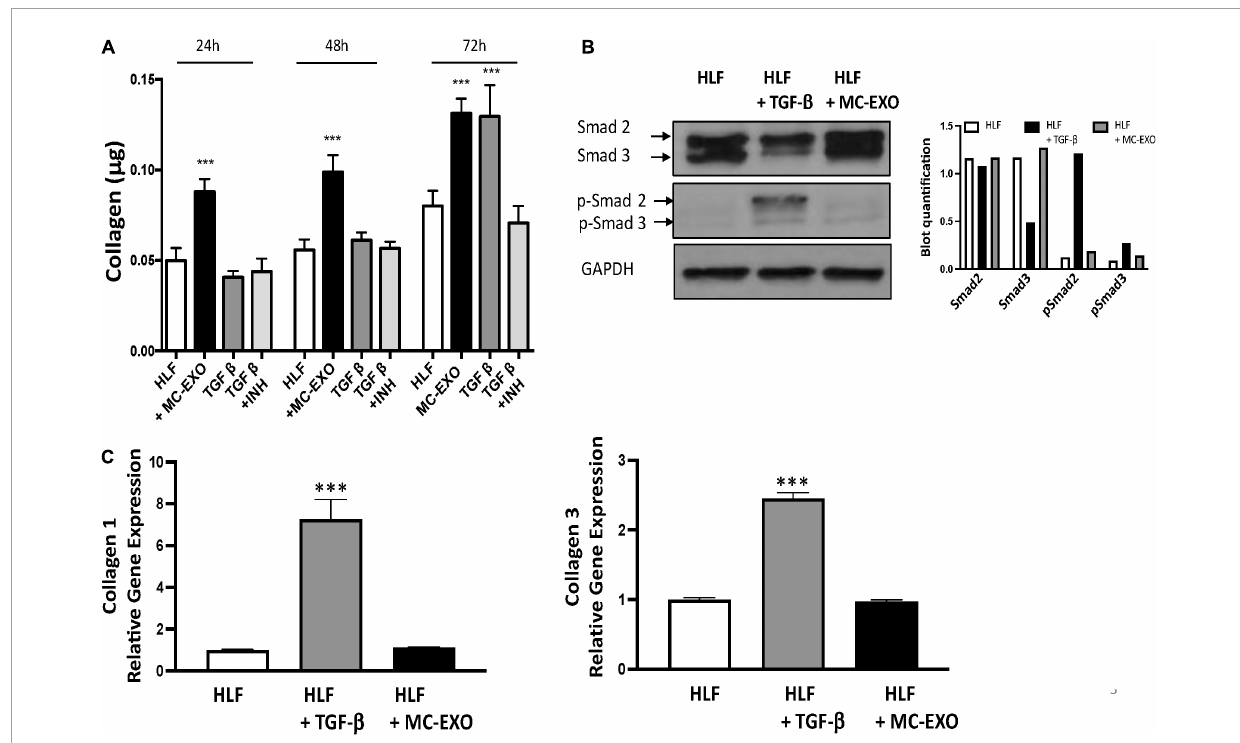
FIGURE3 Uptake of MC-EXO by HLF stimulates collagen synthesis via a Smad-independent pathway and with different kinetics from TGF- β . (A) MC-EXO (40 µ g total protein, black bars) and TGF- β (10 ng/ml, dark gray bars) stimulated collagen secretion in HLFs after 24, 48, and 72 h and in untreated HLFs. Shown is the inhibition of TGF- β stimulated collagen secretion in HLFs by the TGF- β R1 inhibitor SB525334 (TGF- β R1 INH, 10 µ M, light gray bars). All assays performed in triplicate and normalized to total protein ( µ g). ∗∗∗ P < 0.001 versus HLF, n = 6 samples/group. (B) Western blot of HLF lysates at 24 h and after treatment with TGF- β (10 ng/ml) or MC-EXO (40 µ g total protein). Smad 2/3 and p-Smad 2/3 show signaling via the TGF- β pathway. GAPDH is loading control. Western blot was performed twice with associated quantification. (C) Collagen 1 and collagen 3 mRNA expression in HLFs and HLFs treated with either TGF- β or MC-EXO analyzed by RealTime qPCR and normalized to GAPDH mRNA. ∗∗∗ P < 0.001, n = 4 samples/group.